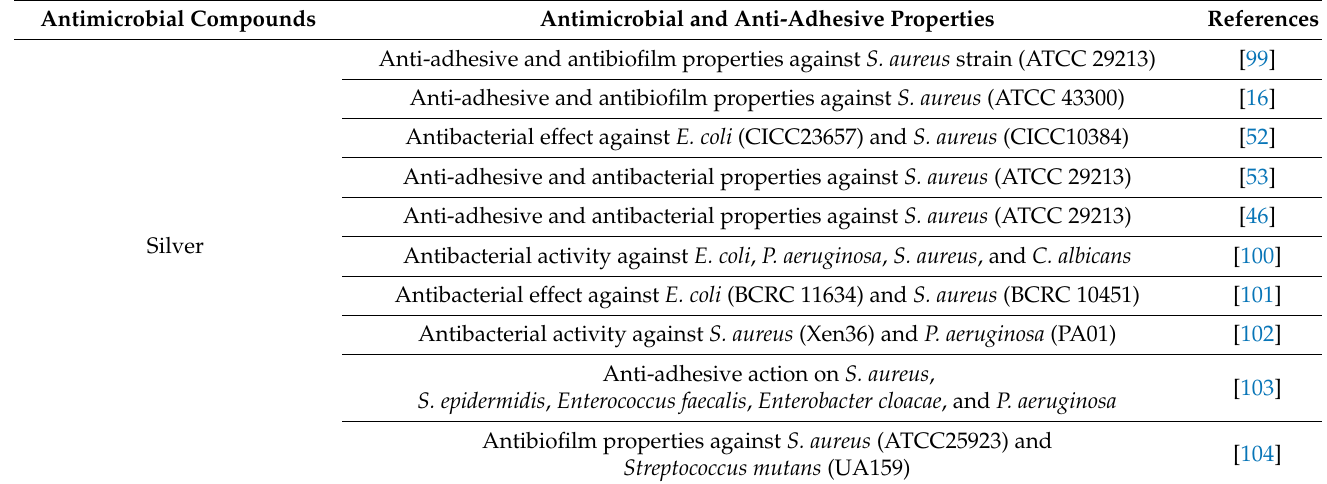
Table 2. Summary of antimicrobial and anti-adhesive compounds added to biomaterials used in orthopedic applications: data on their antimicrobial